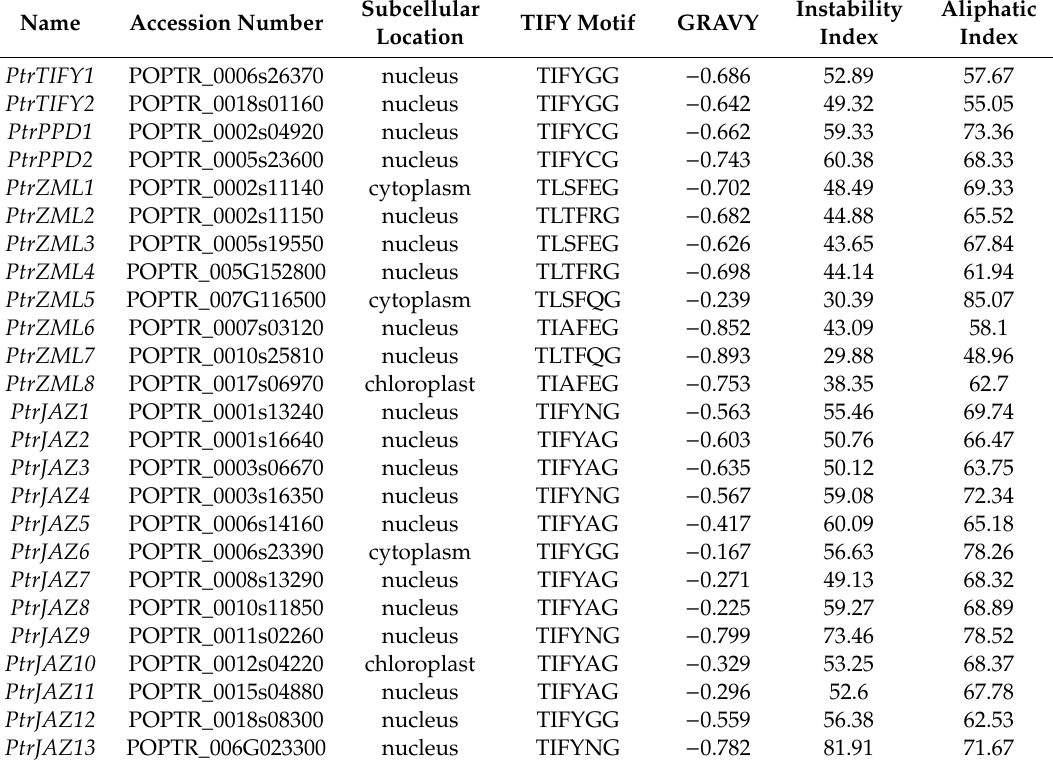
Table 1. Basic information of the TIFY family in P. trichocarp